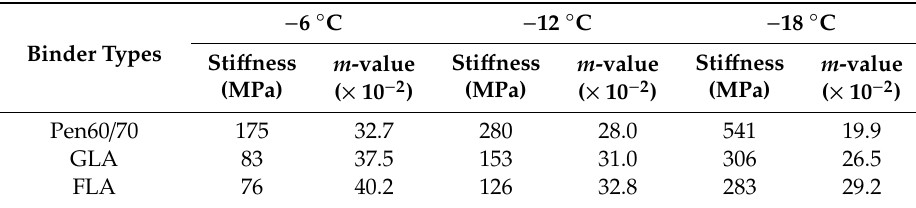
Table 4. Bending beam rheometer (BBR) test